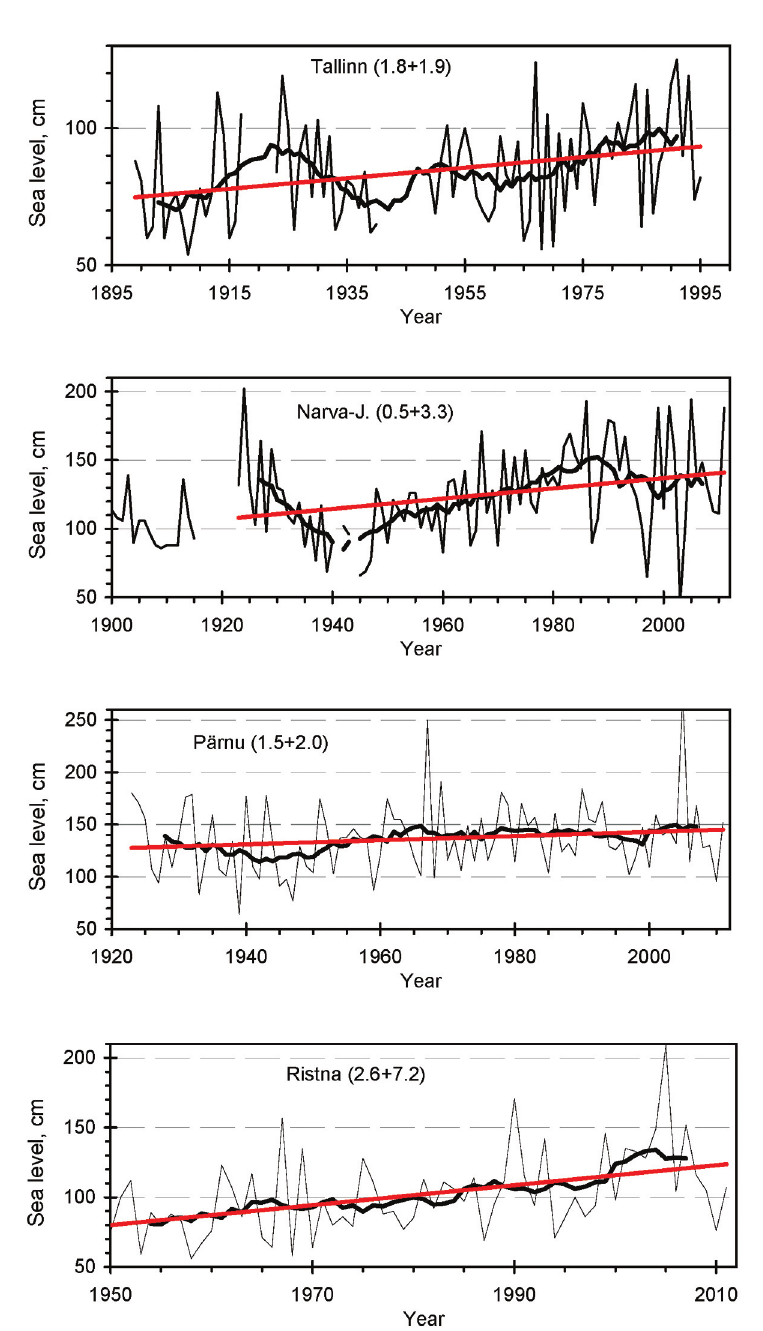
Fig. 8. Time series, 11-year moving averages and linear trend line in the annual maximum sea level data. The sums in parentheses represent the values of land uplift and the linear trend slopes of the sea level data (in mm yr 1